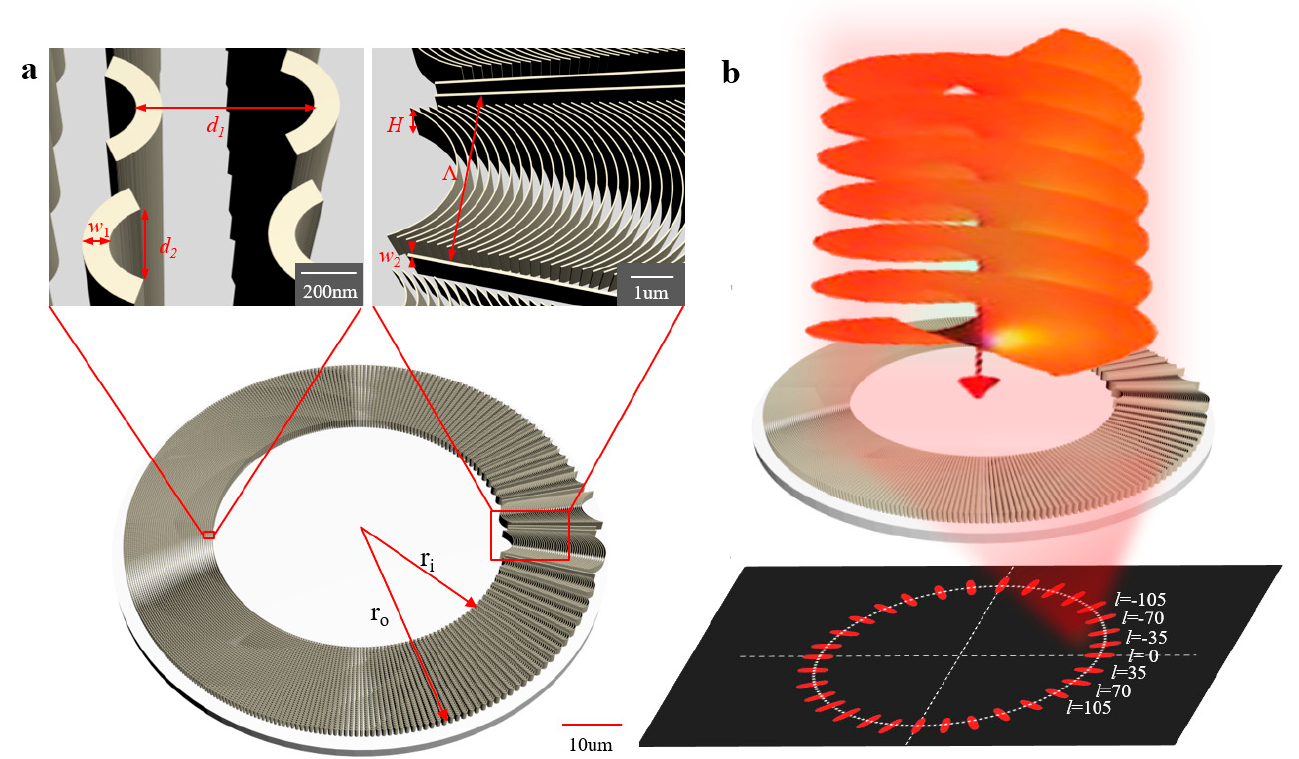
Figure 2. The design of the OSM and PTM detection diagram. ( a ). Schematic diagram of the OSM with SiO 2 substrate. The OSM graphic structure consists of TiO 2 streamline arrays with H = 600 nm, d 1 = 700 nm, w 1 = 100 nm, r i = 50 µ m, and r o = 80 µ m. The streamlines are truncated ( d 2 = 0.75 Λ ) to guarantee the feasibility of fabrication. The vertical structure with width w 2 = 100 nm was added in the truncated region to improve the phase continuity and amplitude uniformity. ( b ). Schematic diagram of the OSM detection, OAMs sequencing by spin-controlled PMT. Vortex beams with different spins are converted into circular focusing modes on the screen in the transverse focal plane with topological charge-dependent azimuth